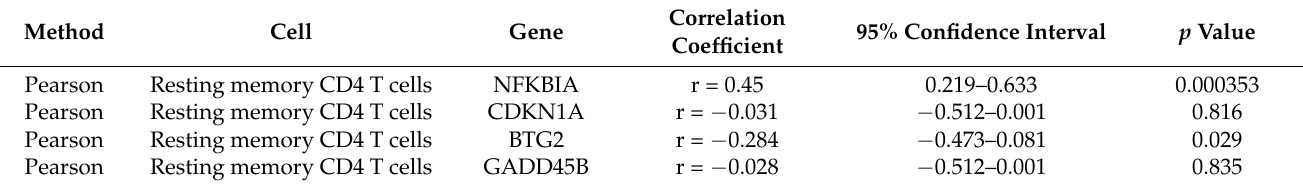
Table 4. Correlation analysis between hub genes and resting memory CD4 T